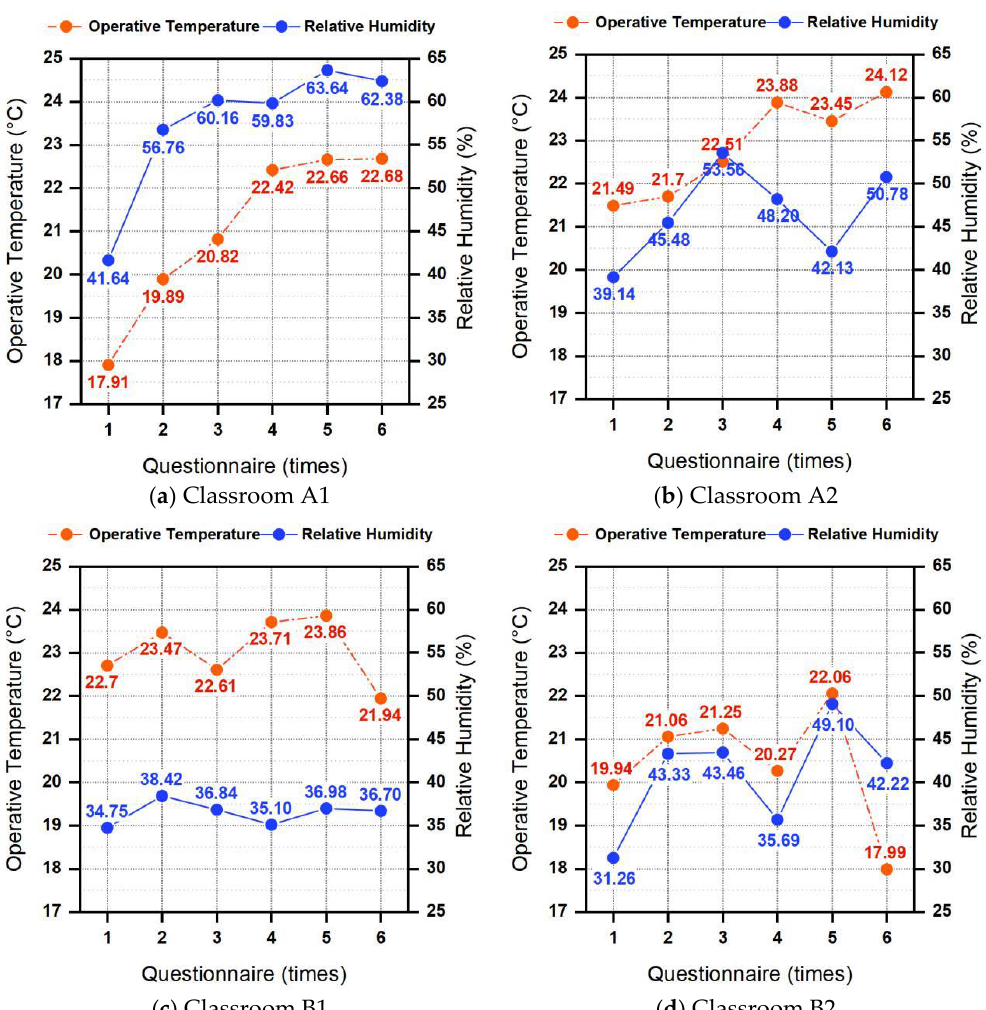
Figure 6. Operative temperature and relative humidity in the 4 selected classrooms during the questionnaire survey.